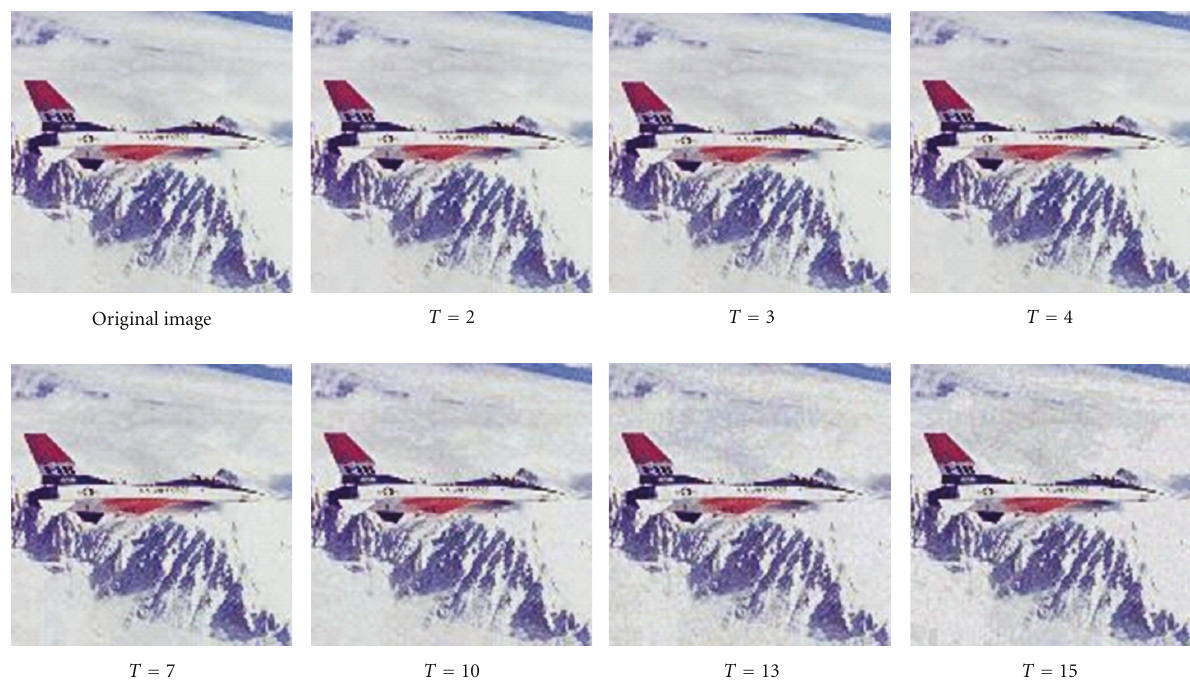
Figure 5: The original airplane image and the stego-images with di ff erent distance